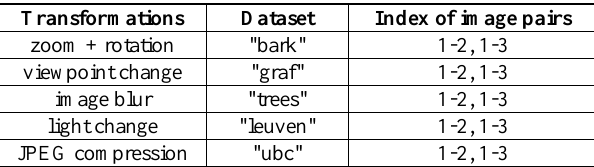
Table 1. Image pairs for performance evaluation.